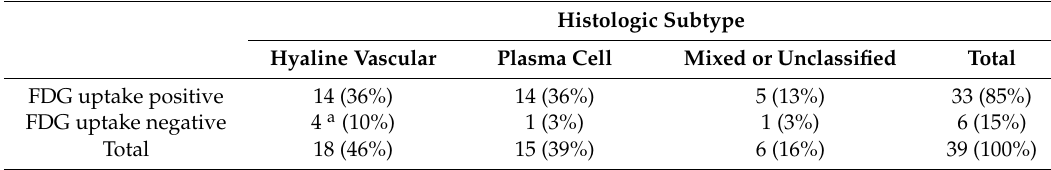
Table 2. Qualitative analysis of fluorine-18 fluorodeoxyglucose (FDG) positron emission tomography (PET) / computed tomography (CT) in treatment naïve patients with CD.